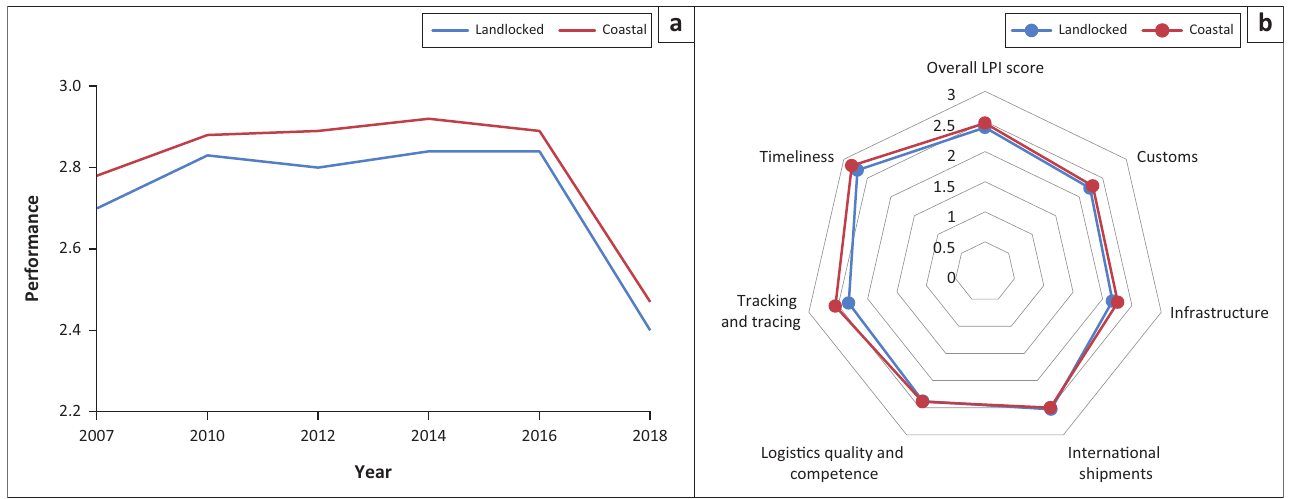
FIGURE 5: (a) Logistics Performance Index of coastal/landlocked and (b) low-income/high-Income African